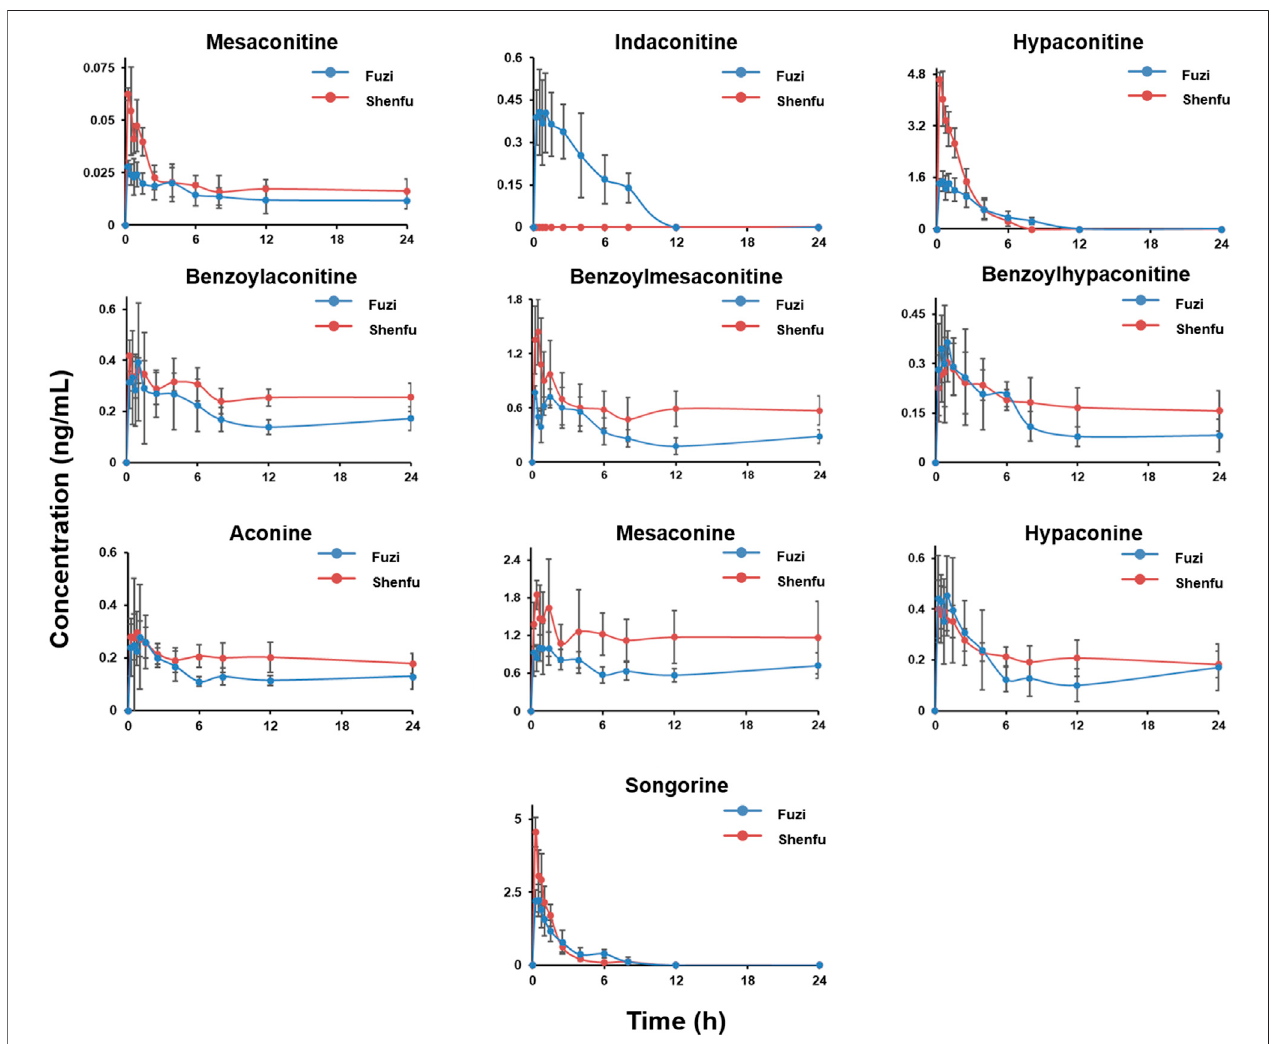
FIGURE 3 | The concentration-time pro fi le of aconitines after oral administration of Fuzi and Shenfu. The dosage of Fuzi is all 2 g/kg in two groups.